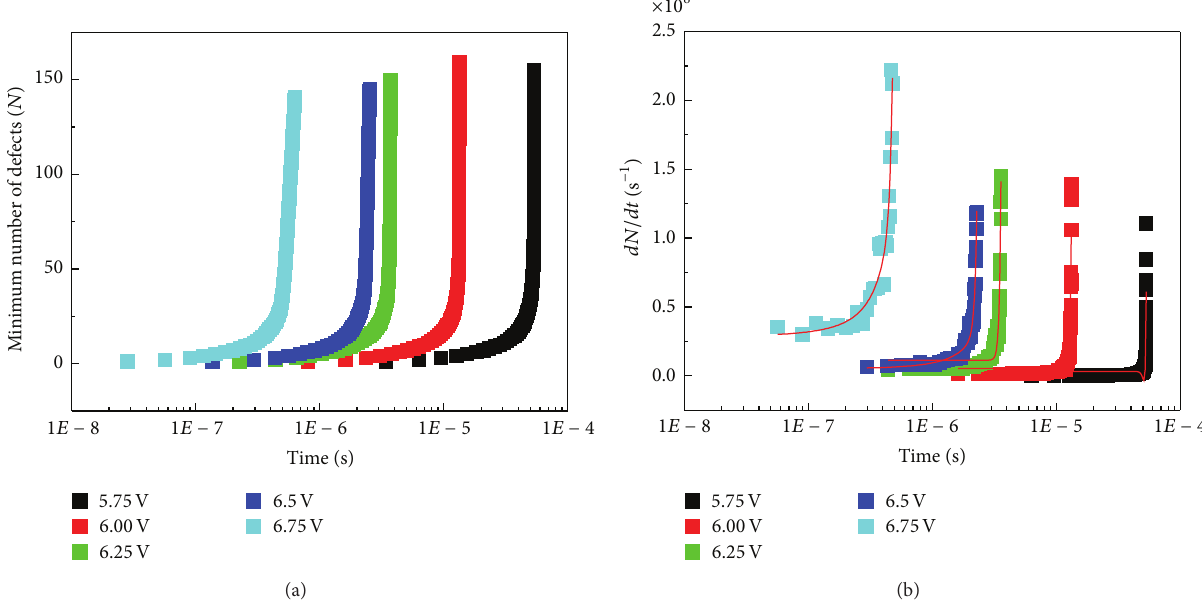
Figure 6: (a) Minimum number of generated defects as function of time, for different operation voltages. (b) Calculated rates (symbols) and simulated derivatives (lines) of the curves drawn in (a).